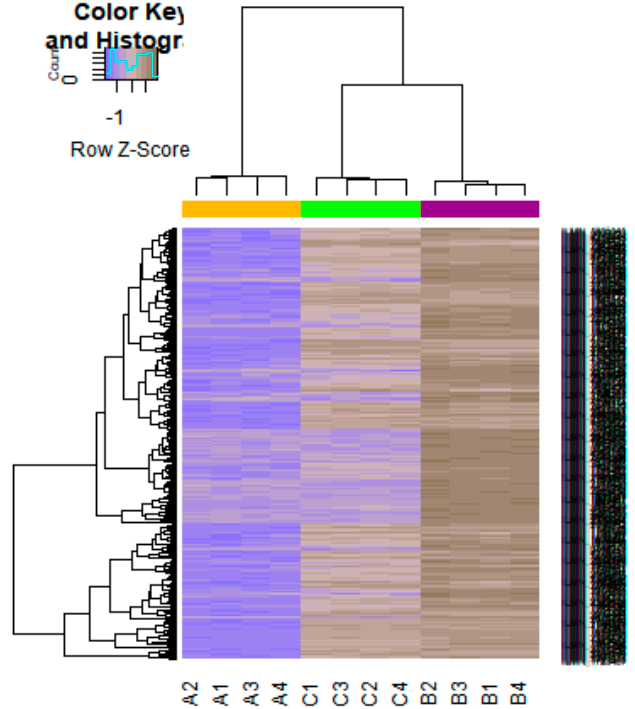
Figure 3. Heat map of gene expression (Down-regulated genes). The color key represents the logFC ofDEGs. FC, fold change (A1, A2, A3, A4 = high-grade ovarian epithelial cancer, B1, B2, B3, B4 = normal fallopian tube samples, C1, C2, C3, C4 = normal ovarian epithelium samples).